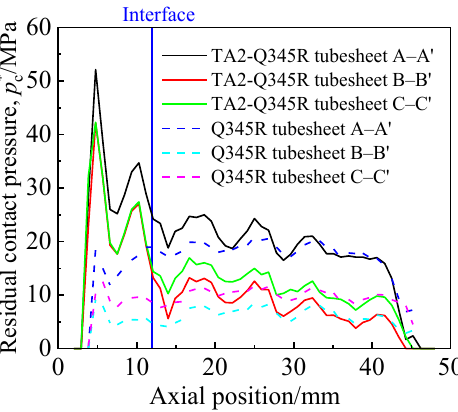
Figure 7. Axial distribution of residual contact pressure of the two kinds of tubesheets. Figure 8 indicates the p c * on the circumferential paths D – D′ (tube side) and E – E′ (shell side) on two sealing rings. The results show that the p c* of the shell side of the two